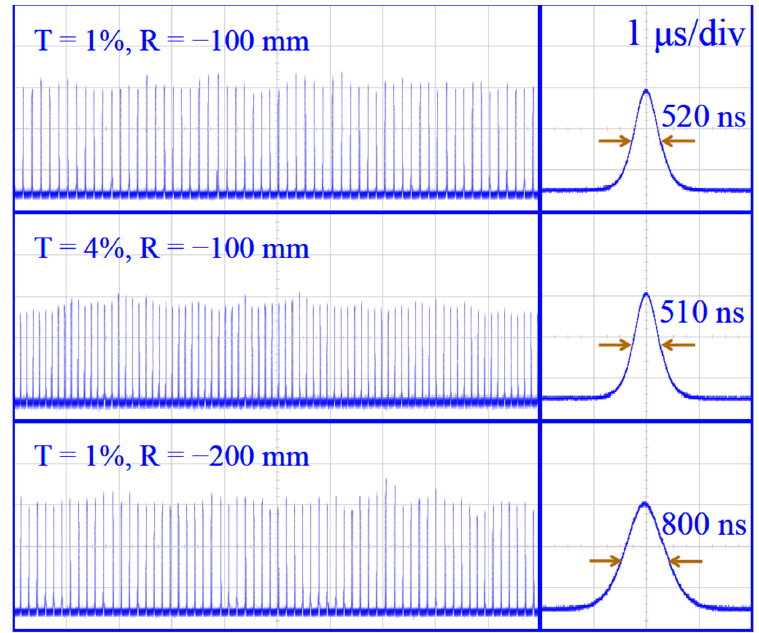
Figure 5. Typical pulse trains and temporal pulse profiles displayed by the oscilloscope.